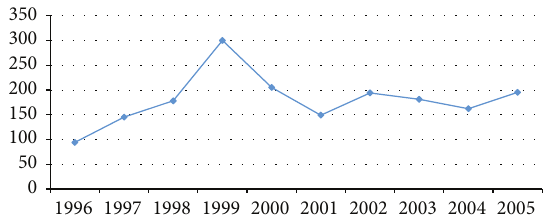
Figure 1: Number of screening visits at the Jamaica Cancer Society per year